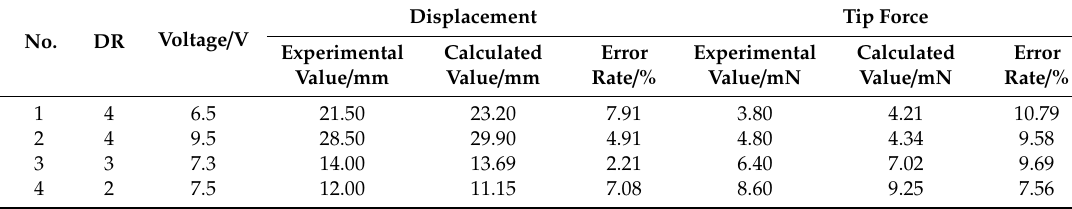
Table 2. Comparison of experimental values.and calculated